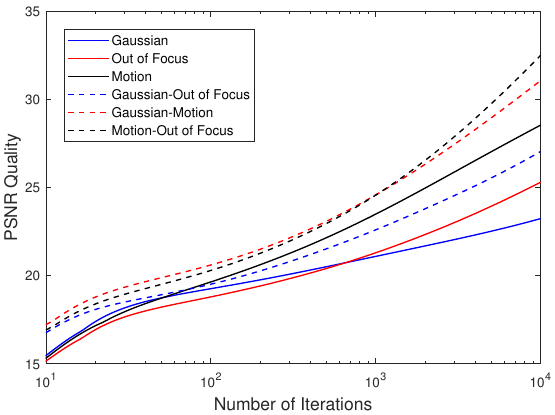
Figure 35. PSNR quality plots of the proposed algorithm in all cases of RGB